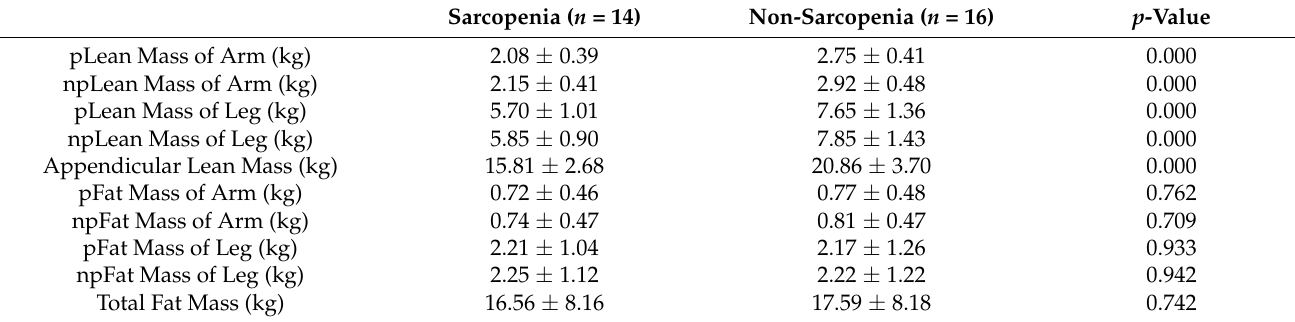
Table 2. DEXA measurements between subjects with and without